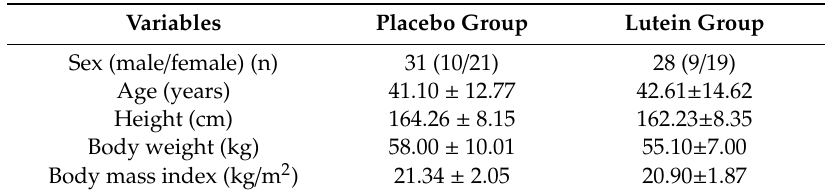
Table 3. Subject characteristics.